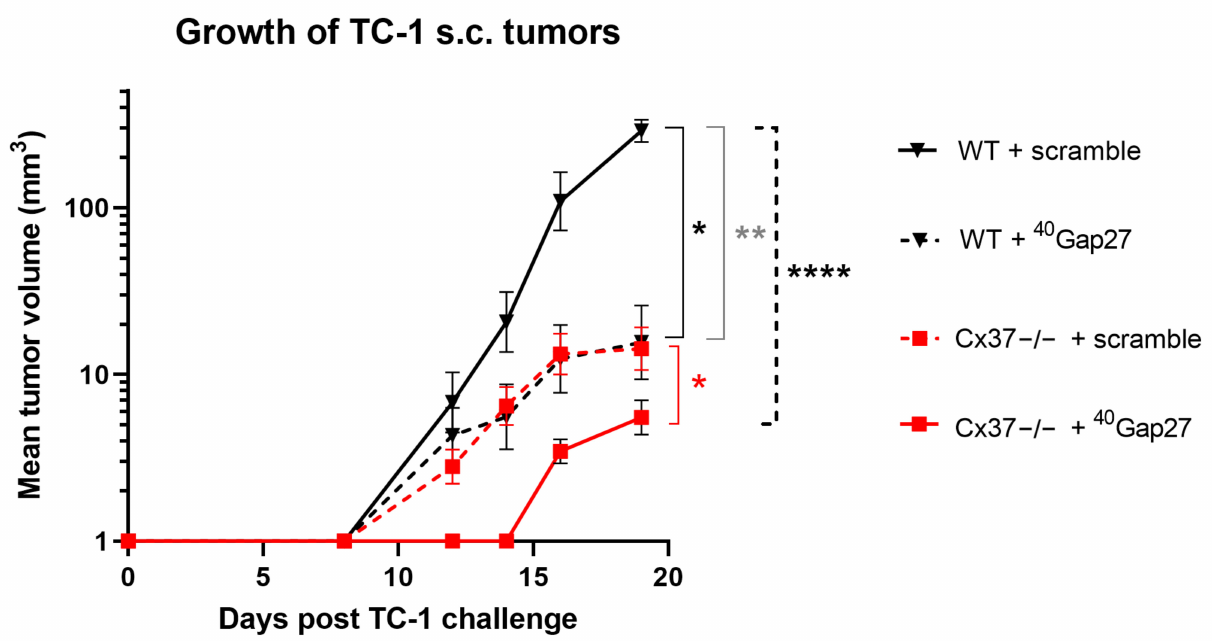
Figure 7. A peptide targeting Cx40 function decreases tumoral growth in Cx37 − / − mice. One day after the s.c. injection of TC-1 cells, WT ( n = 12, black lines) and Cx37 − / − mice ( n = 16, red